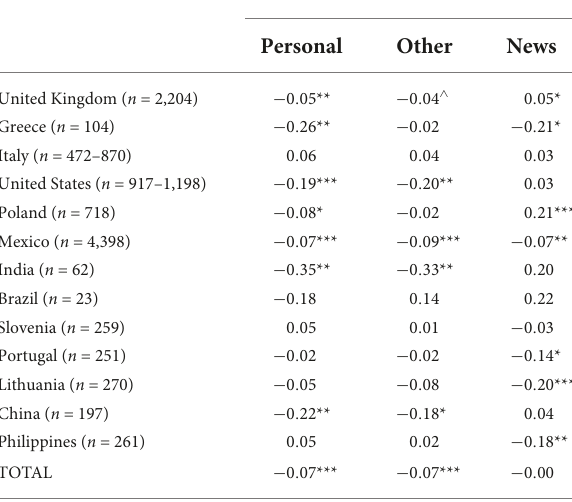
TABLE 3 The relationship of age with COVID experiences across